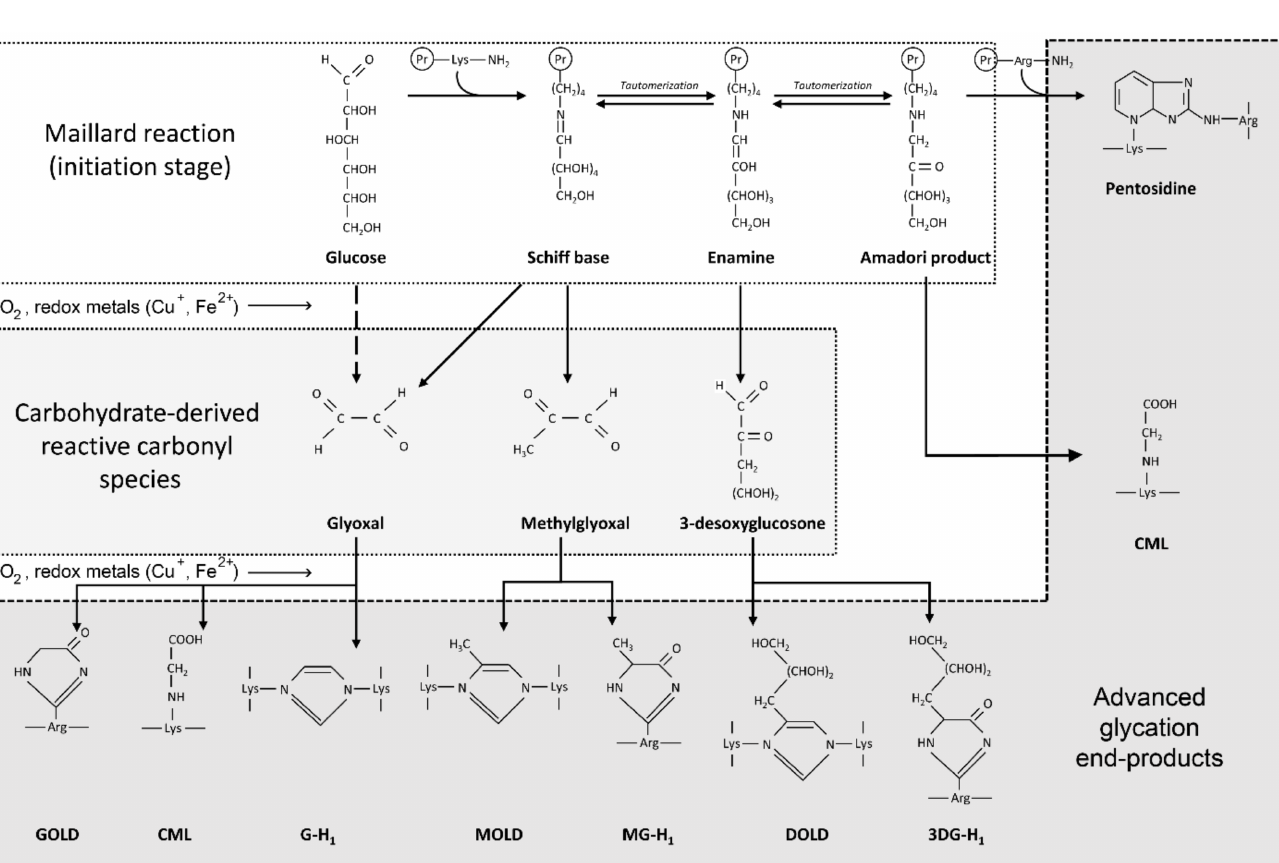
Figure 1. Schematic representation of the mechanisms of AGE formation through the Maillard reaction and reactive carbonyl mediated protein modification. Briefly, the reaction between the protein free amino group and carbonyl group of a reducing carbohydrate (glucose) results in formation of a Schiff base. The latter is subsequently rearranged to a more stable Amadori product that yields AGEs including carboxymethyllysine (CML) or pentosidine in a series of reactions. In addition, carbohydrate-derived reactive carbonyls that are formed from glucose and Schiff bases also interact with protein molecules resulting in formation of numerous AGEs including glyoxal-derived di-lysine imidazolium crosslink (GOLD), CML, glyoxal-derived hydroimidazolone (G-H1), methylglyoxal-derived di-lysine imidazolium crosslink (MOLD), methylglyoxal-derived hydroimidazolone (MG-H1), desoxyglucosone lysine dimer (DOLD) and 3-deoxyglucosone-derived hydroimidazolone 1 (3DG-H1). Formation of AGEs as well as carbohydrate-derived carbonyl species is stimulated by redox metals including copper and iron, which are involved in Fenton chemistry, as well as by oxidative